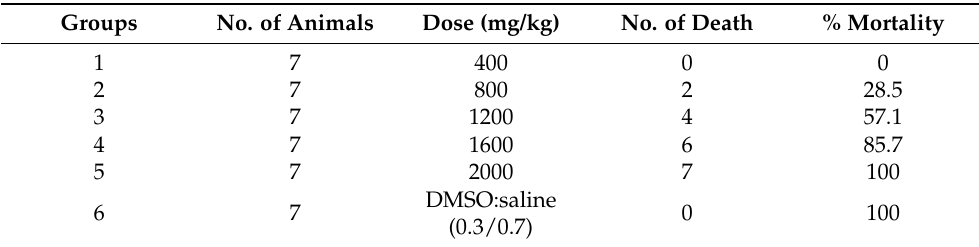
Table 3. Percentage mortality in Swiss albino mice given indoloquinoline analog 6d (subcutaneously (SC)) at different doses.